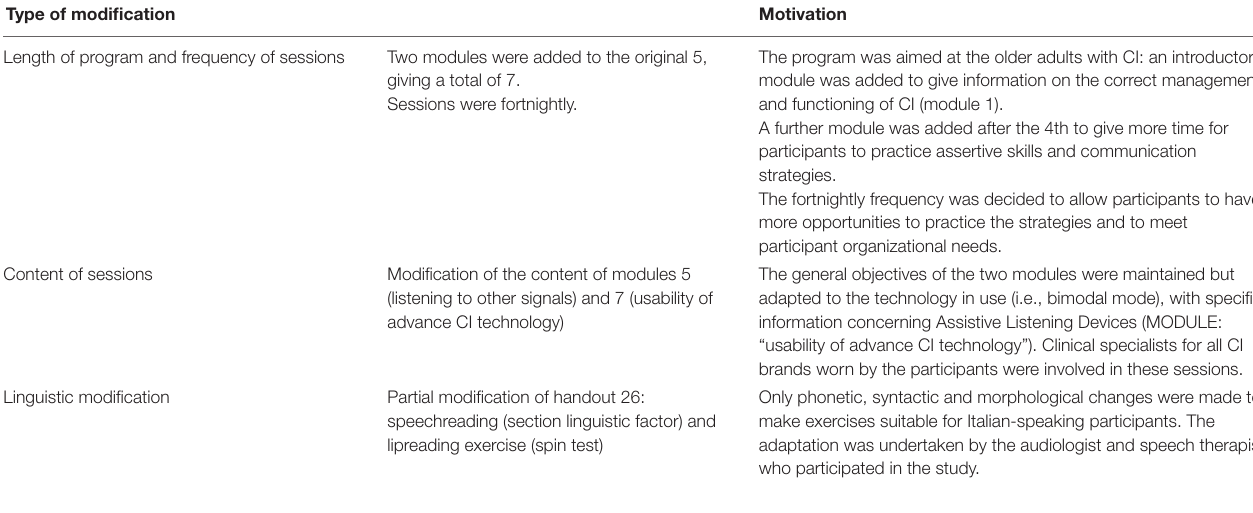
TABLE 1 | Summary of main modifications compared to the original ACE